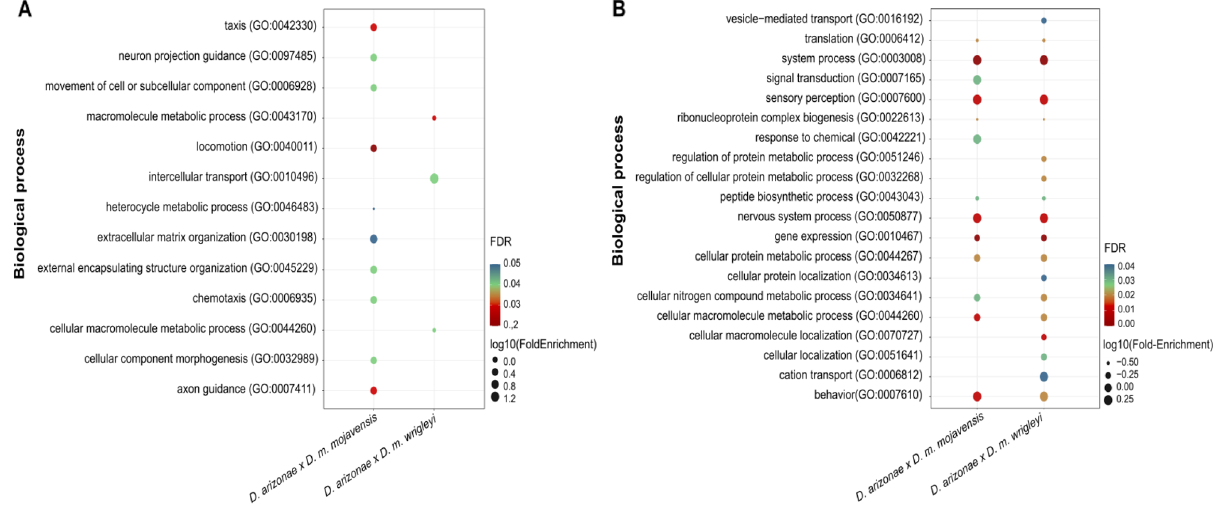
Figure 3. GO term enrichment analysis of DEGs between D. arizonae and D. mojavensis subspecies. Dot plot representing GO enrichment for the biological process category for DEGs in ( A ) ovaries and ( B ) testes between D. arizonae - D. m. mojavensis and D. arizonae- D. m. wrigleyi (FDR < 0.05). The dot plot was generated using the ggplot2 package (version 3.3.3) in R 79